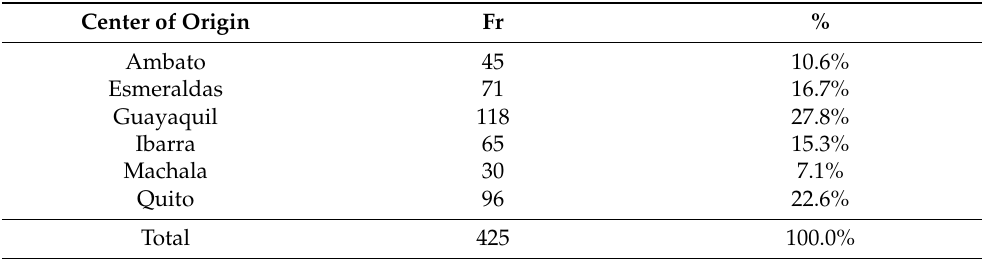
Table 1. Center of origin of the adolescents.